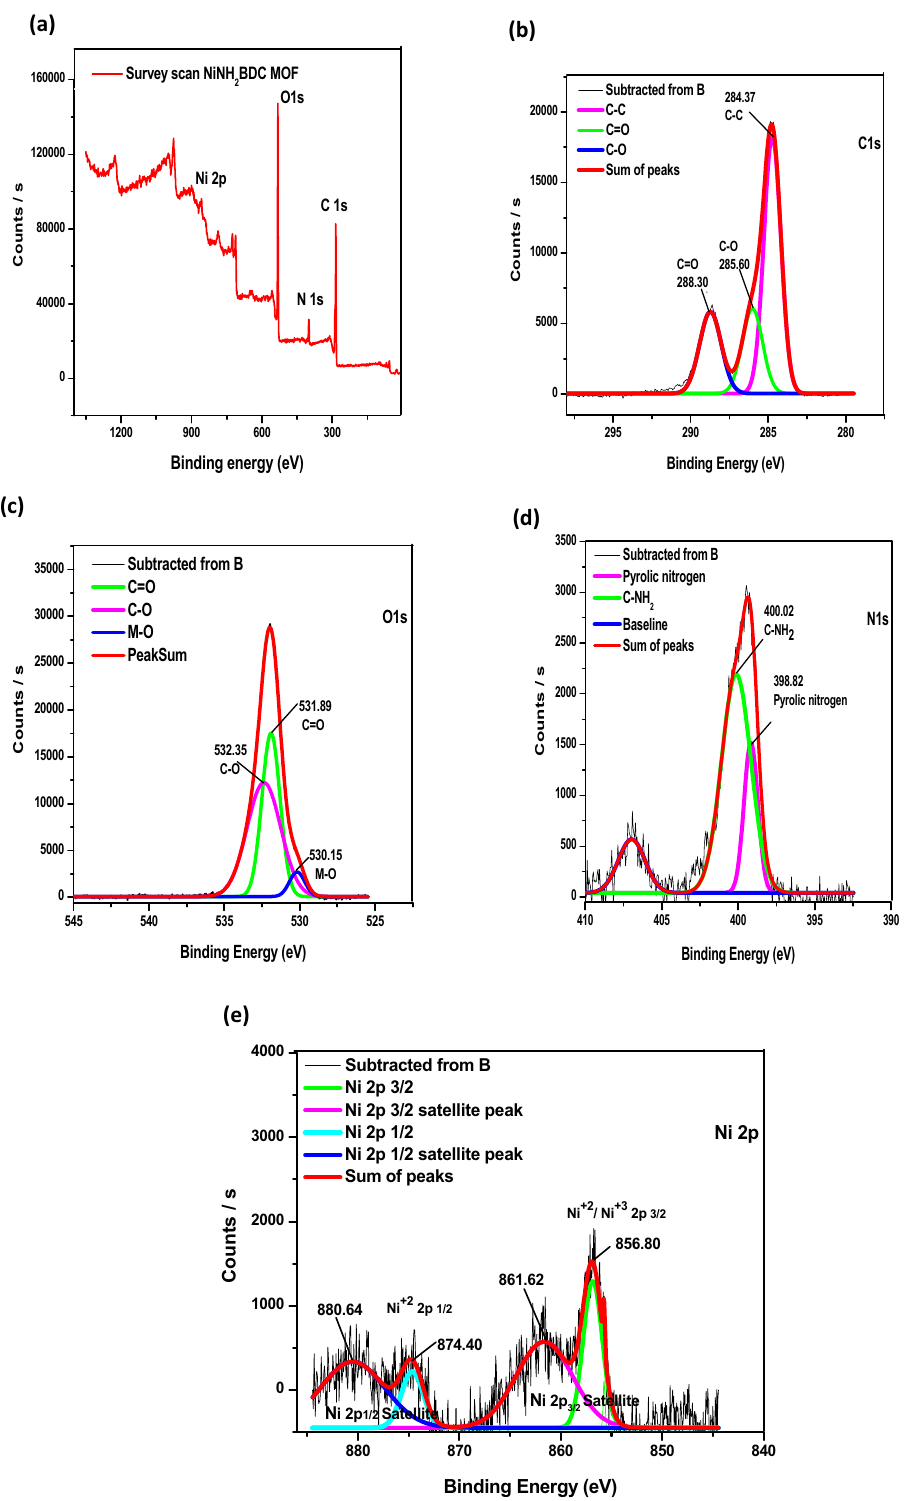
Figure 4. X-ray photoelectron spectra of NiNH 2 BDC ( a ) Survey scan ( b ) Carbon ( c ) Oxygen ( d ) Nitrogen, and ( e )